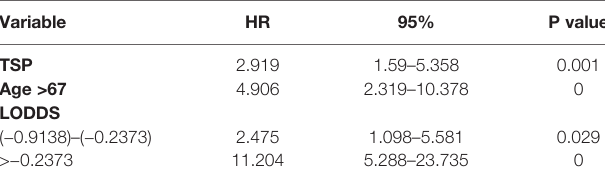
TABLE 4 | Multivariate Cox regression analyses of risk factors associated with overall survival in RSCC.